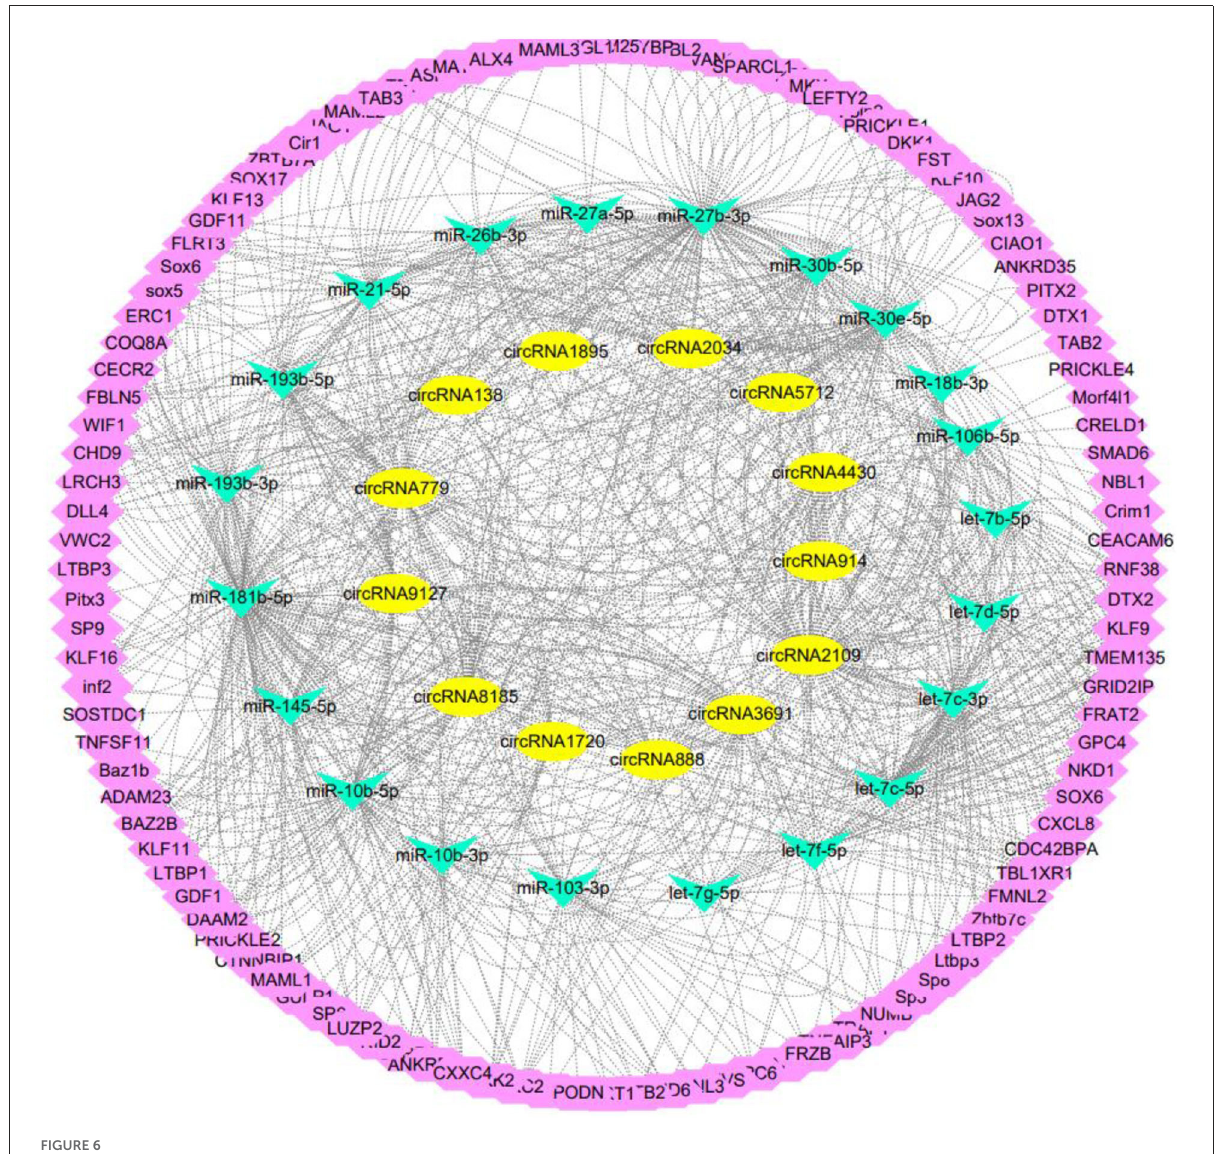
FIGURE6 ceRNA regulatory network related to secondary hair follicle